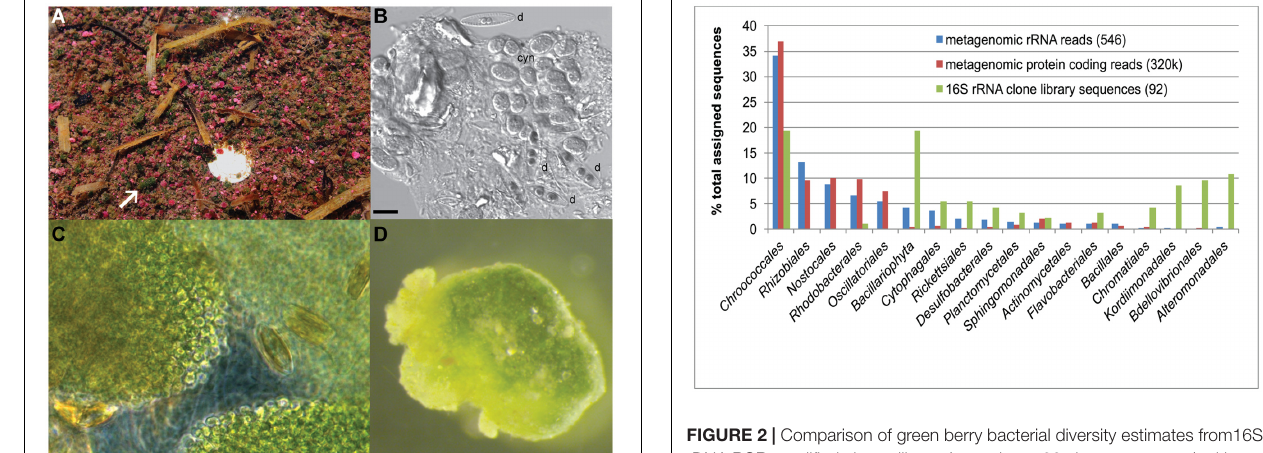
FIGURE 2 | Comparison of green berry bacterial diversity estimates from16S rDNA PCR amplified clones library (green bars; 92 clone sequences) with unassembled Roche 454 metagenomic sequence reads. Taxonomic assignment of metagenomic reads matching ribosomal RNA reads (16S/18S/23S) was conducted using the M5RNA database in MG-RAST (blue bars; 546 assigned reads). A similar taxonomic assignment was conducted with metagenomic reads matching protein coding sequences in the M5NR database (red bars; 319,692 assigned reads). Note that the 16S rRNA clone library abundance data for the Bacillariophyta (green bar, asterisk) was obtained from diatom chloroplasts sequences, which are likely present in multiple copies in the cell and thus not directly comparable to metagenomic 18S rRNA sequences for this group (blue